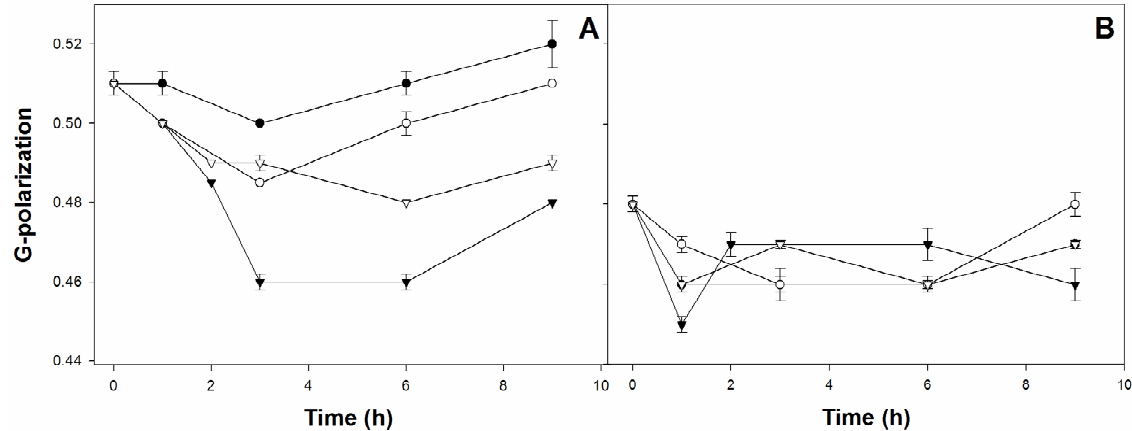
FIGURE 10. The change in GP of laurdan-labeled cells that were grown in the absence (nonadapted, A) or presence (adapted, B) of benzene, and then challenged with increasing concentrations of benzene — 300 mg/l ( (cid:1) ), 600 mg/l ( (cid:2) ), 1000 mg/l ( (cid:1) ), 1400 mg/l ( (cid:2) ). Where SD error bars are not shown, it is because they were smaller than the